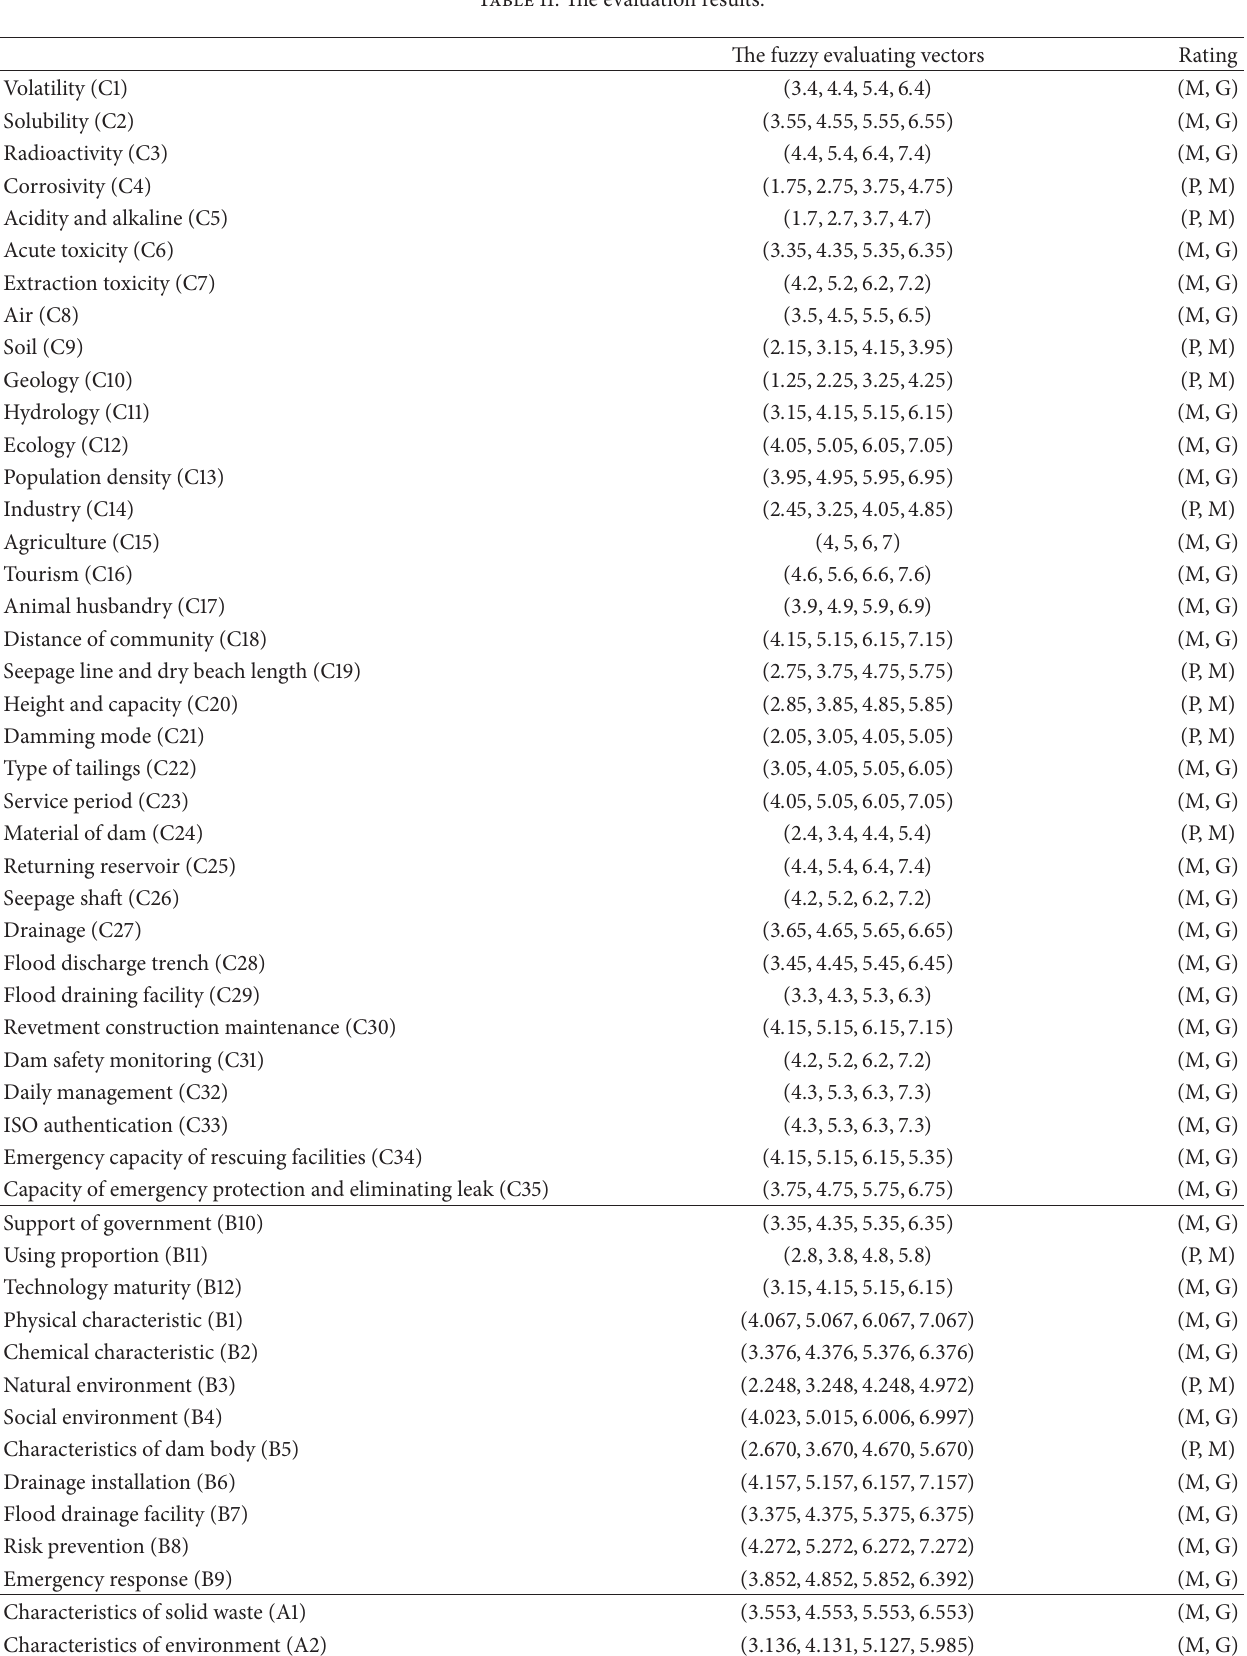
Table 11: The evaluation